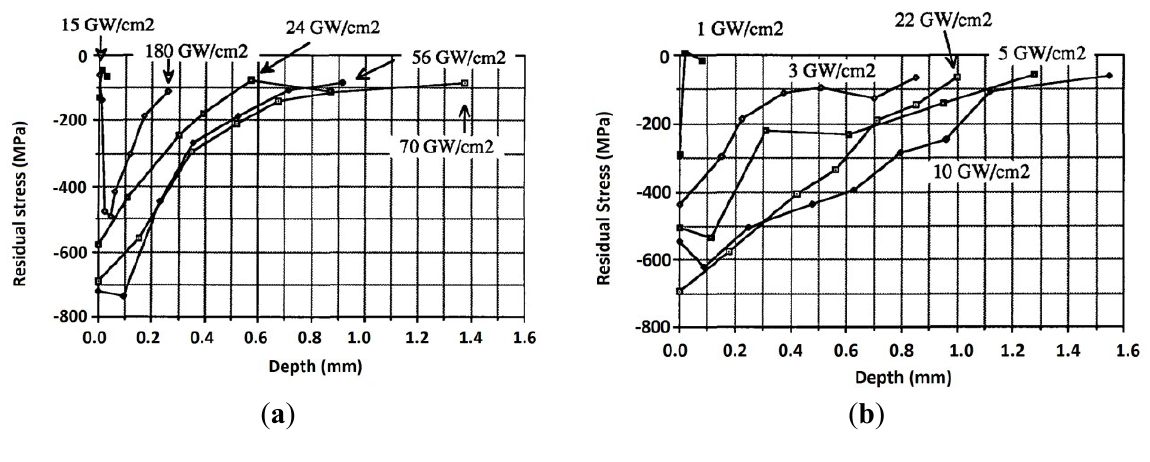
Figure 5. Stress distribution profile vs. depth after 2.5 ns ( a ) and 25 ns ( b ) laser irradiation